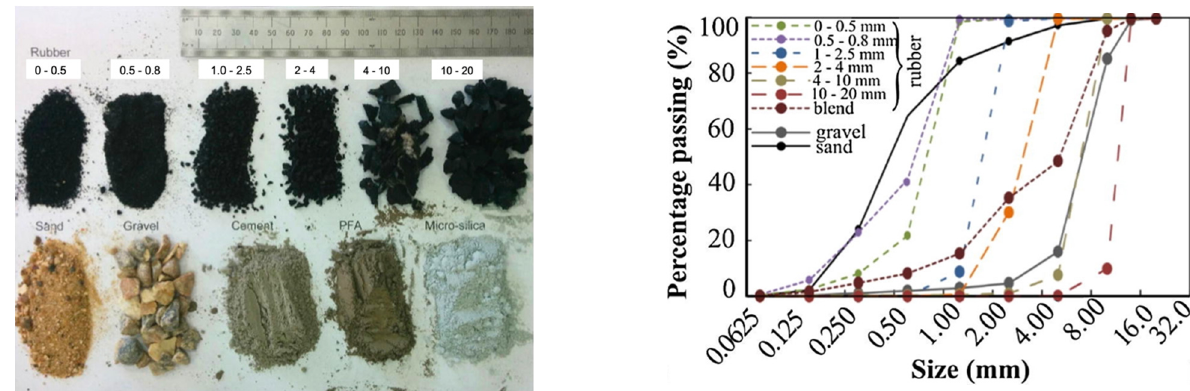
Figure 3. Comparison of tire rubber particles with other aggregates used in concrete mix. Reprinted with permission from [36]. Copyright© 2019, Elsevier B.V.